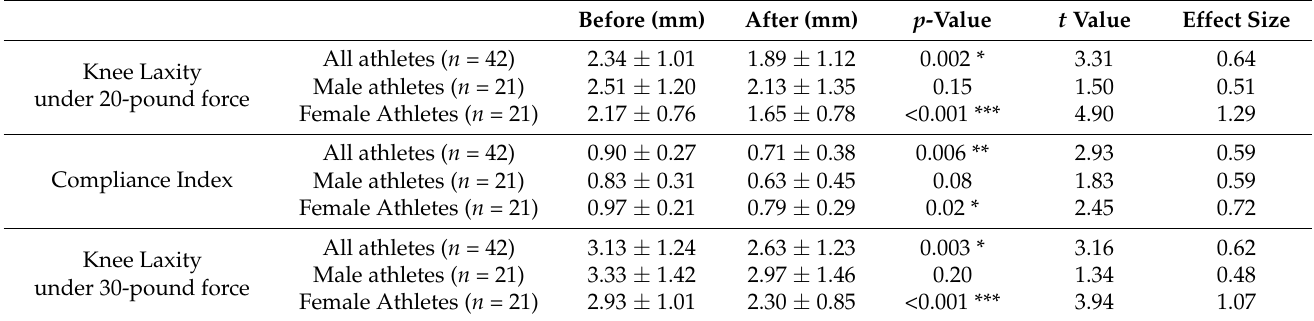
Table 5. The anterior–posterior knee laxity and compliance index of the dominant leg before and after dynamic